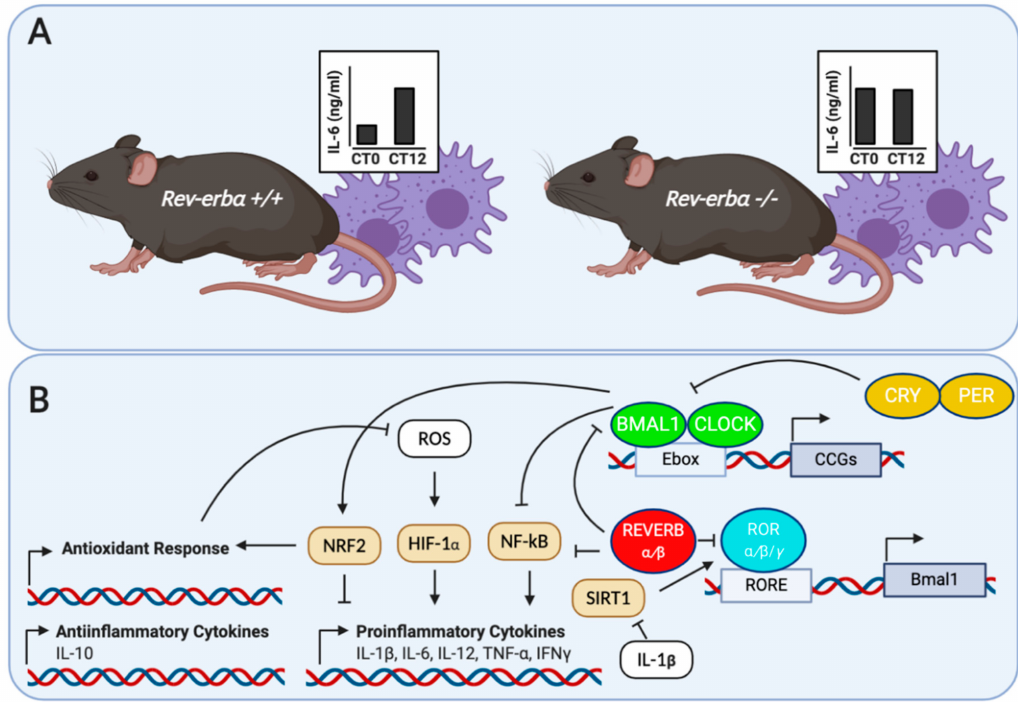
Figure 1. ( A ) Loss of temporal gating of IL-6 cytokine response in serum and macrophages from Rev-erb α + / + and Rev-erb α − / − in response to LPS. Adapted from Gibbs et al. [15]; ( B ) molecular regulation of cytokines and oxidant response in inflammatory cells by circadian clock proteins. BMAL1 and REV-ERB α control the inflammatory response by down-regulating NF- κ B-mediated transcription in inflammatory cells. In addition, BMAL1 regulates the IL-1 β response in